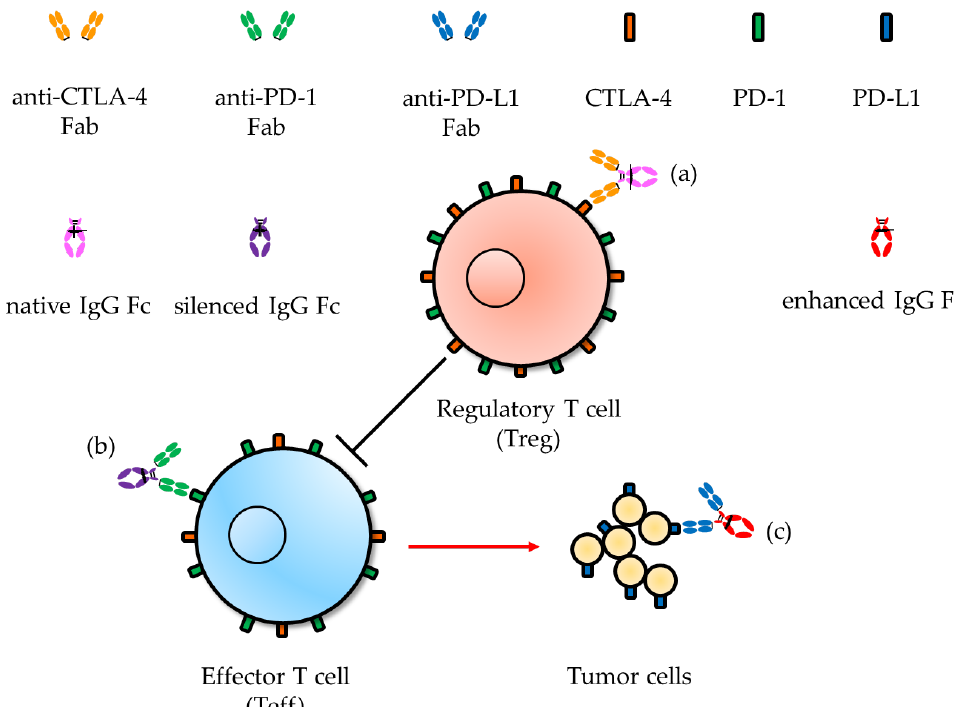
Figure 2. Proposed Fc function on immune-checkpoint blocking antibodies targeting ( a ) CTLA-4, with FcγR-mediated clearance of regulatory T (Treg) cells; ( b ) PD-1, with minimized antibody-dependent cell-mediated cytotoxicity (ADCC) or antibody-dependent cell-mediated phagocytosis (ADCP) activity on effector T (Teff) cells; ( c ) PD-L1, with enhanced ADCC or ADCP activity on tumor cells.